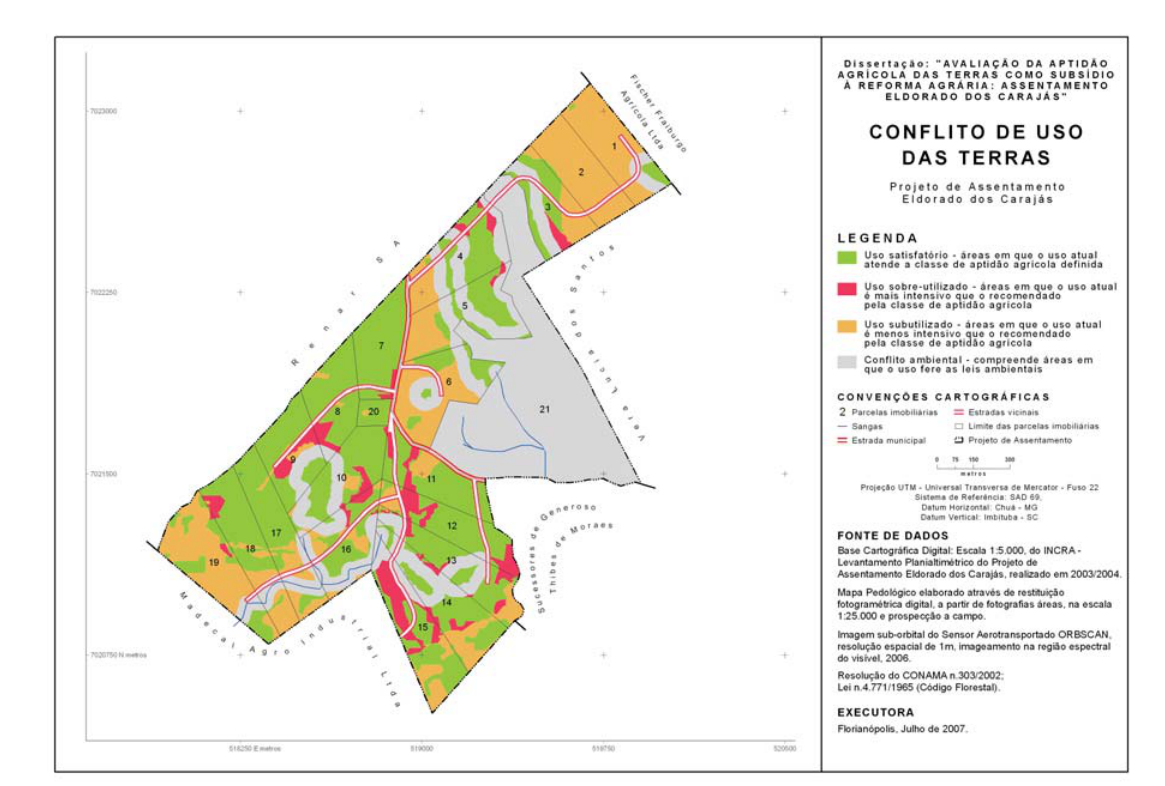
Figura 5. Mapa de conflito de uso das terras do